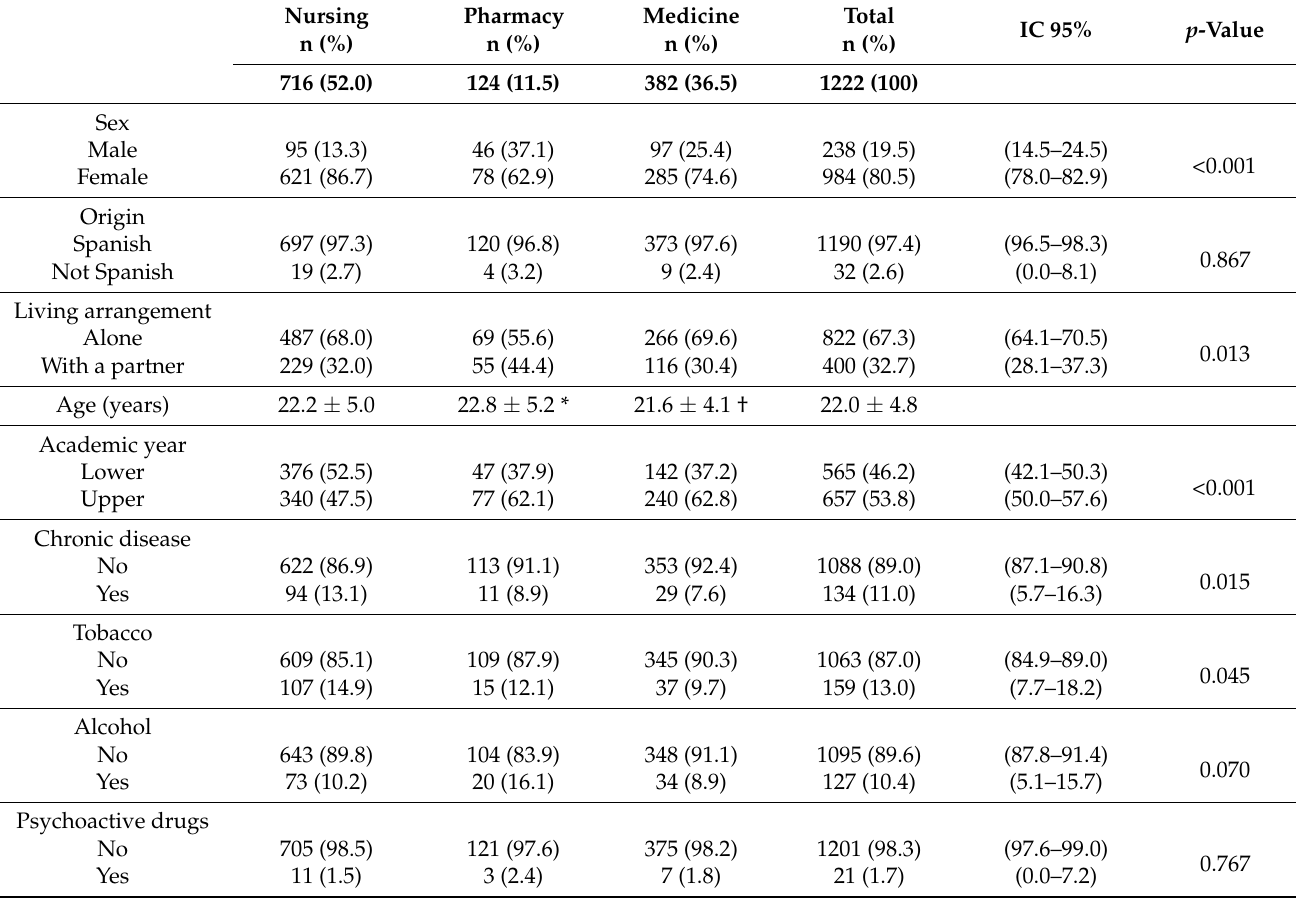
Table 1. Demographic characteristics of college students (n =